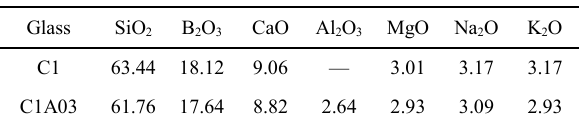
Table 1 Glass compositions of C1 and